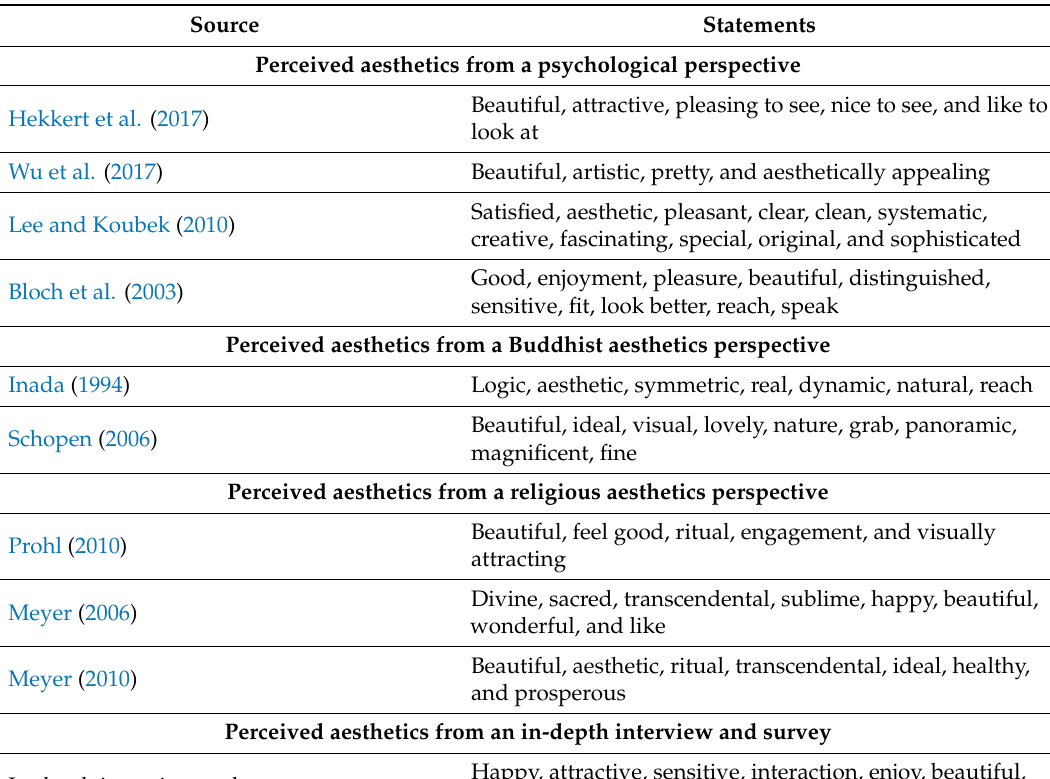
Table 1. Measurement item categories, keywords, and